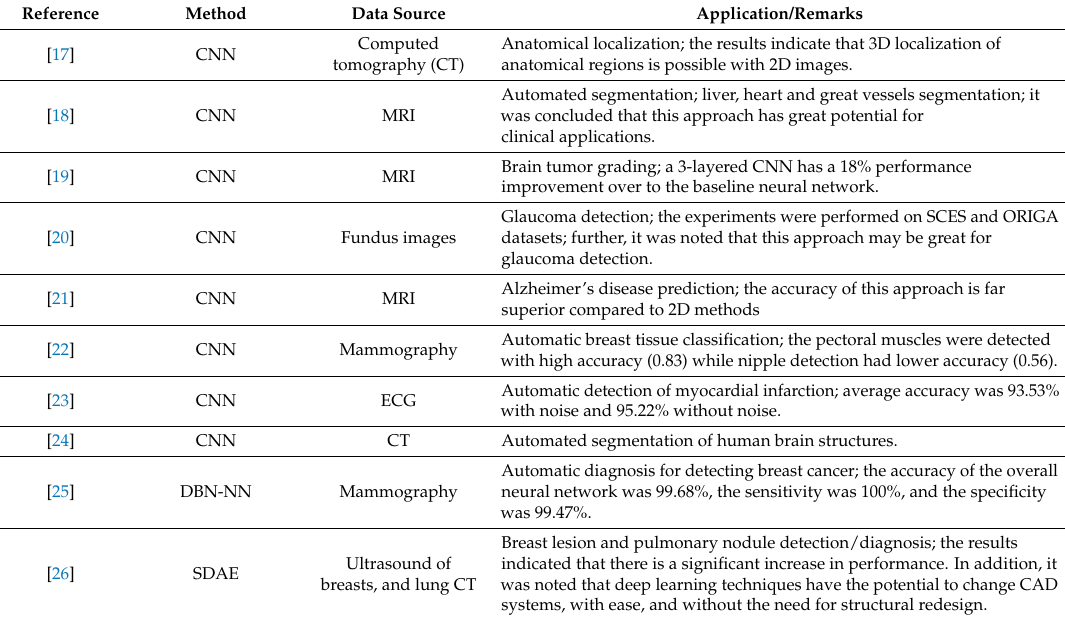
Table 2. Results of individual articles in the domain of deep learning and medical